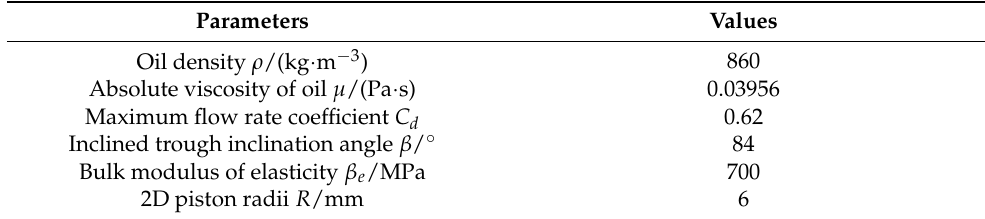
Table 1. Constant parameters used for calculation formulas.